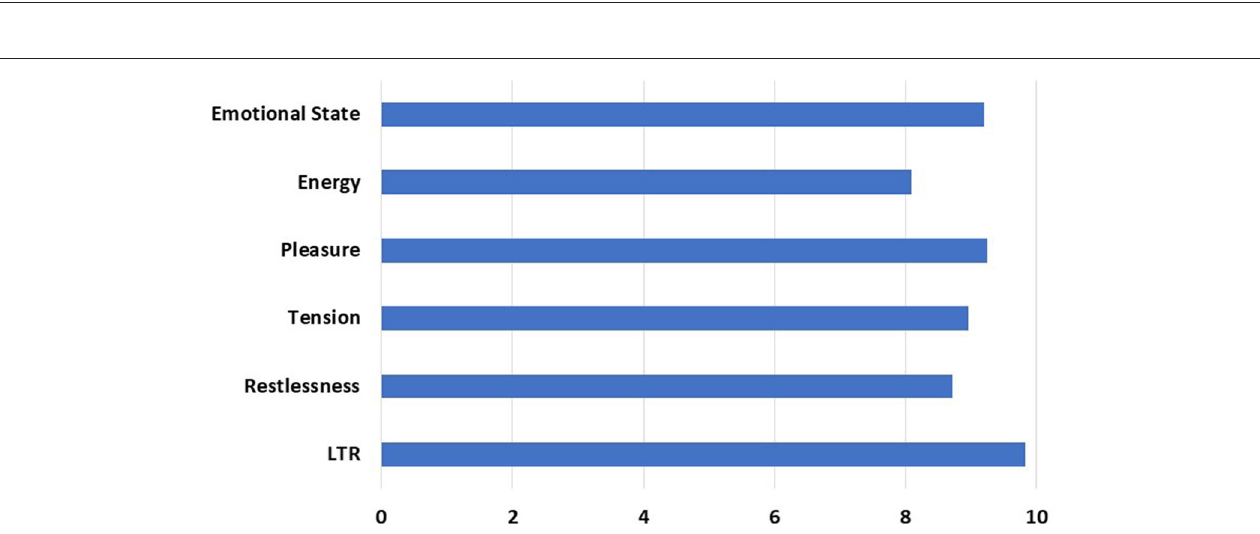
FIGURE 4 | Distribution of music preferences based on age. Classical and Jazz were requested with greater frequency in patients who were 46 above. R&B was the most consistently preferred across all ages. Pop and Rock genres were mostly requested by individuals in the 18–30 years old age range.